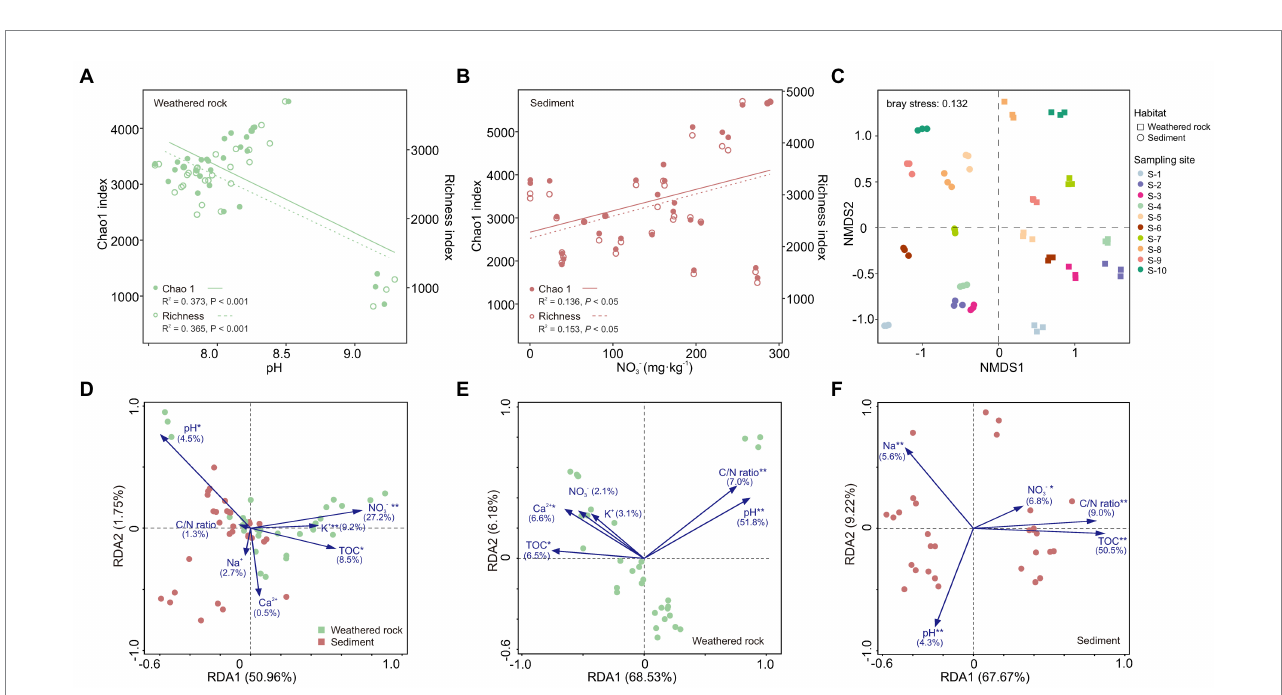
FIGURE 2 Bacterial diversities in weathered rock and sediment samples and redundancy analysis (RDA) of bacterial communities and environmental variables in the Chang Cave, Hubei province. (A) Linear regression analysis of alpha diversity indexes and pH in weathered rocks. Solid circles and solid lines: Chao1 index; hollow circles and dashed lines: Richness index. (B) Linear regression analysis of alpha diversity indexes and nitrate in sediments. (C) Non-metric multidimensional scaling (NMDS) ordination plot of bacterial communities based on Bray-Curtis dissimilarities. The squares represent weathered rock, the circles represent sediments, and the colors distinguish sampling locations. Redundancy analysis between environmental variables and bacterial communities at the class level in all samples (D) , weathered rocks (E) and sediments (F) . Significance level: p < 0.05, *; p < 0.01, **; p < 0.001, ***. Green: weathered rocks; red,